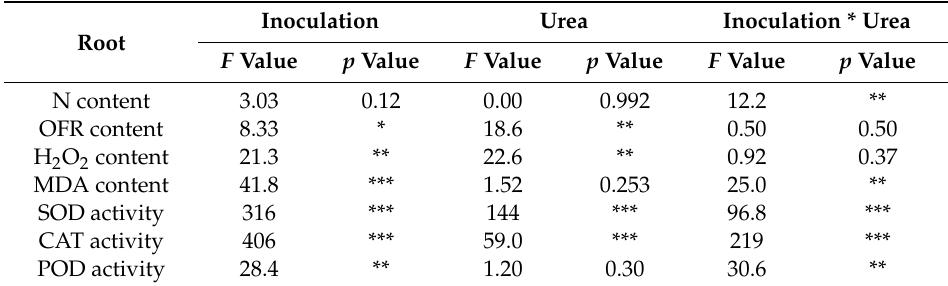
Table 5. The significance of the urea and rhizobium treatments (and interaction) on plant roots.